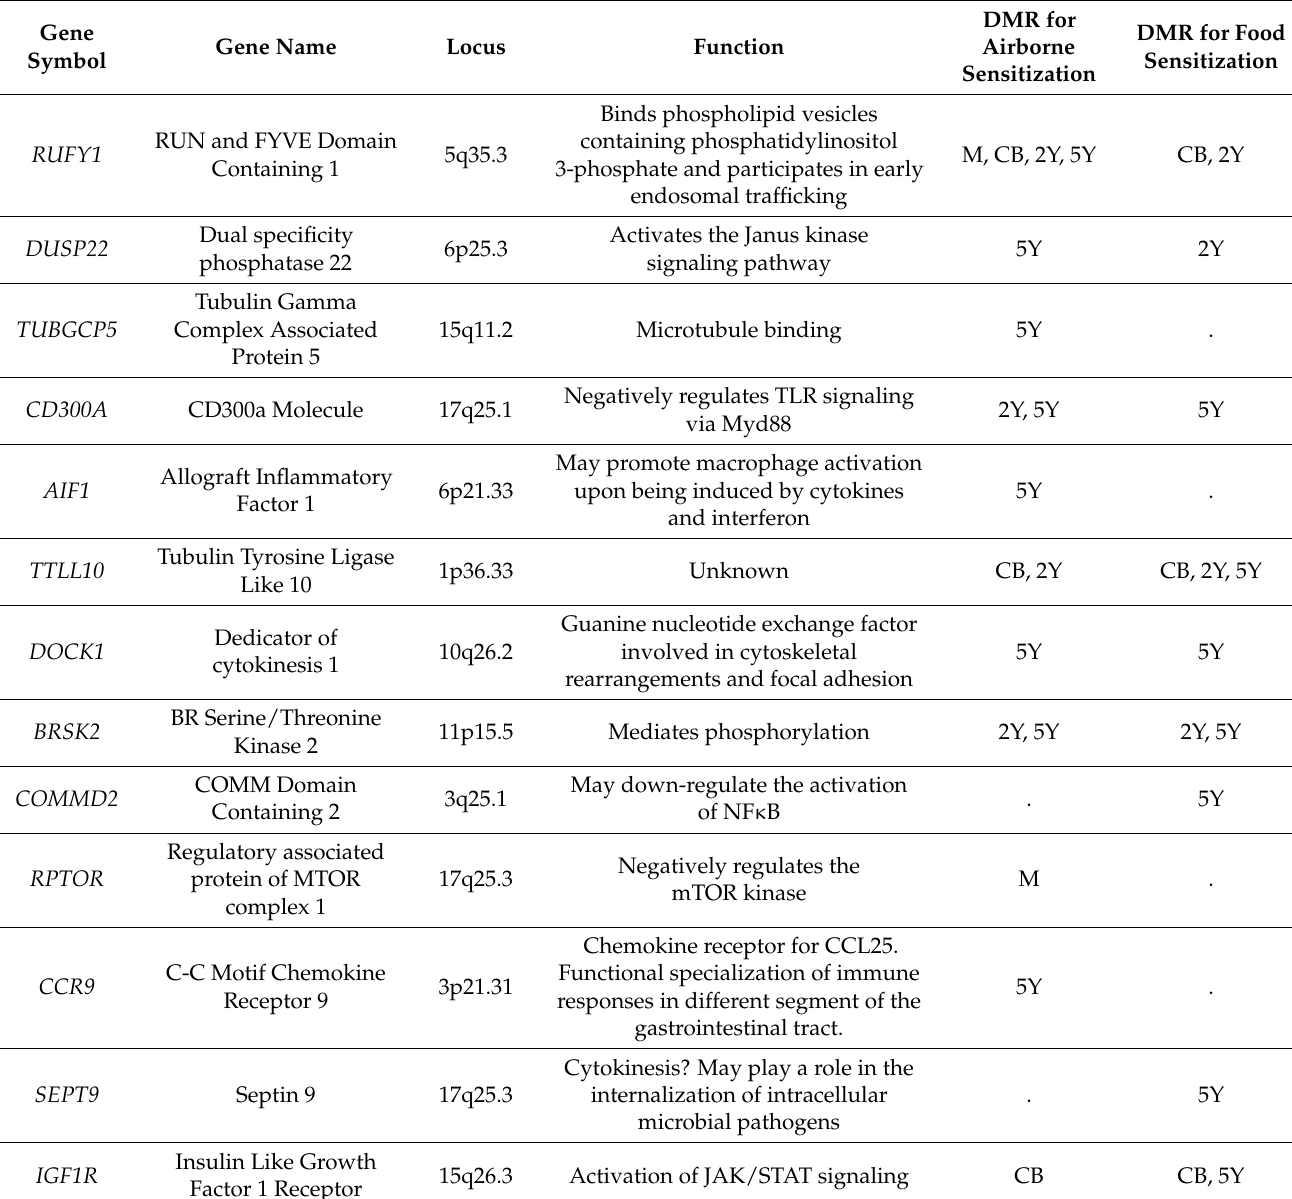
Table 5. A summary of genes containing DMPs and/or DMRs associated with IgE sensitization to airborne and food allergens in